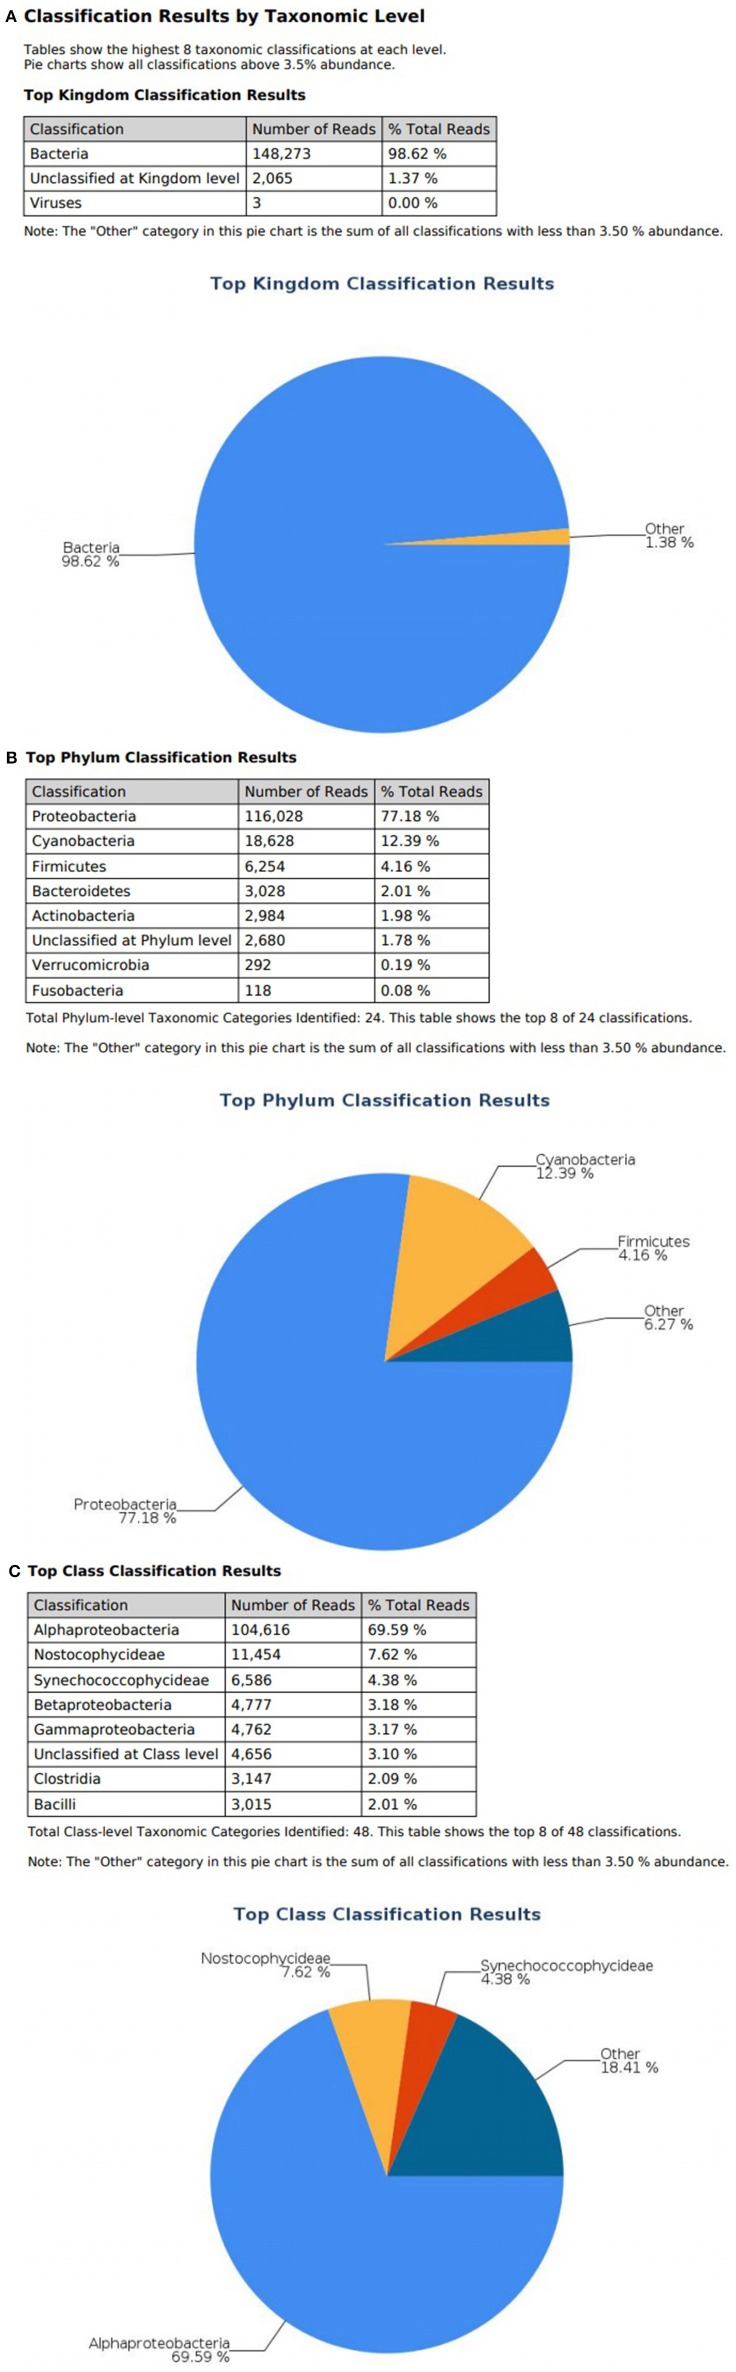
illumina® 16S Metagenomic report on effluent wastewater; classification at the level of: (A) Kingdom (B) Phylum (C) Class.